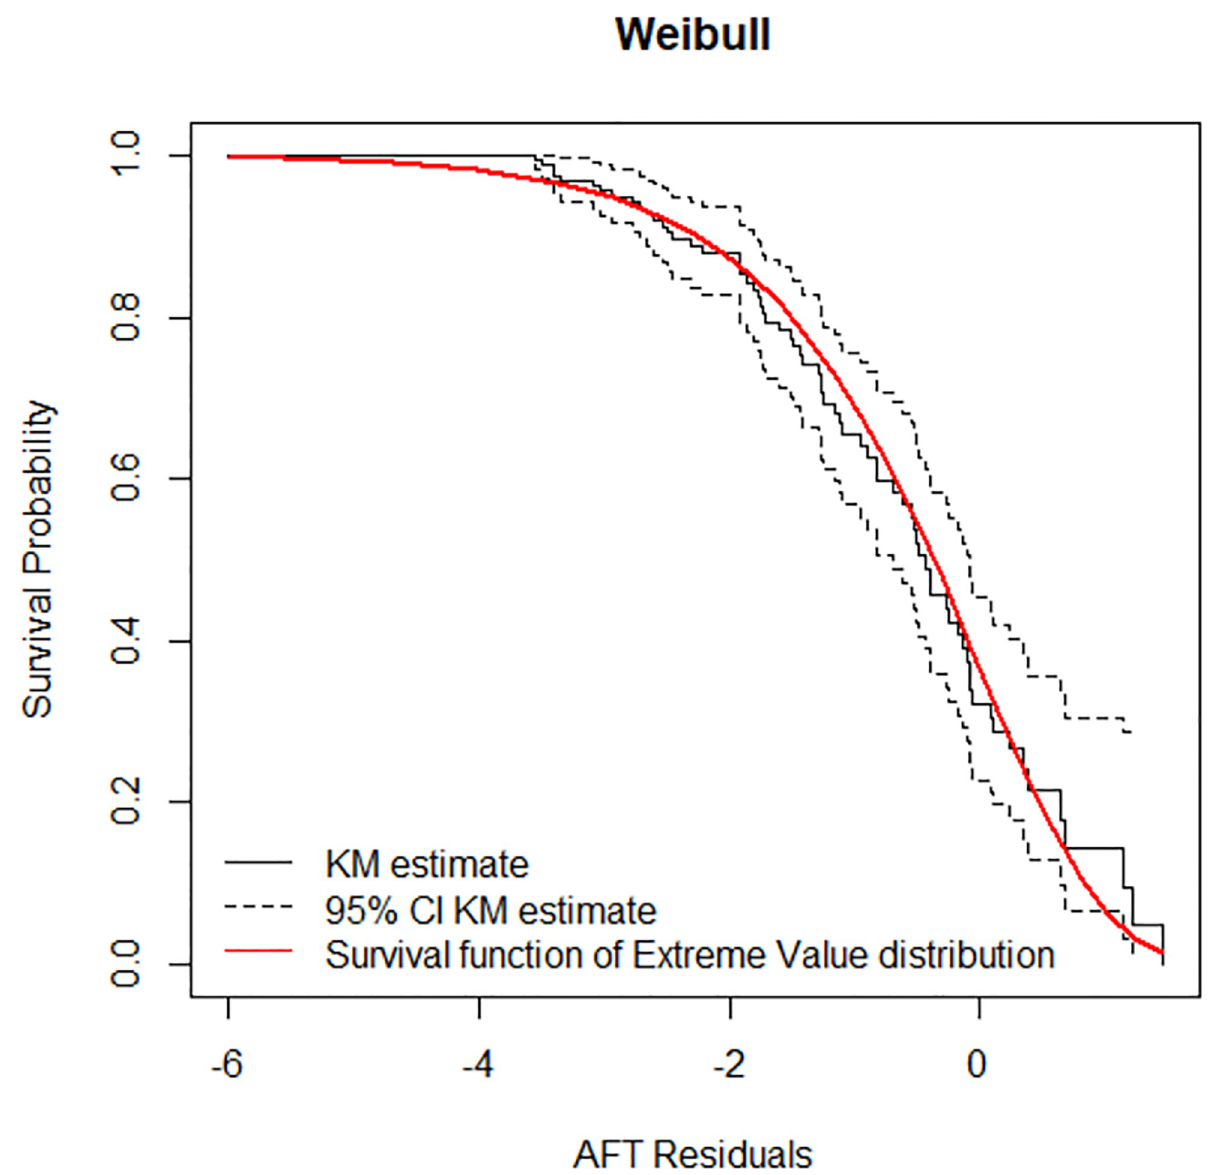
Fig 4. Estimated cumulative hazard plot of the Cox-Snell residuals for the Weibull baseline distribution, LPAC, 2015–2019.